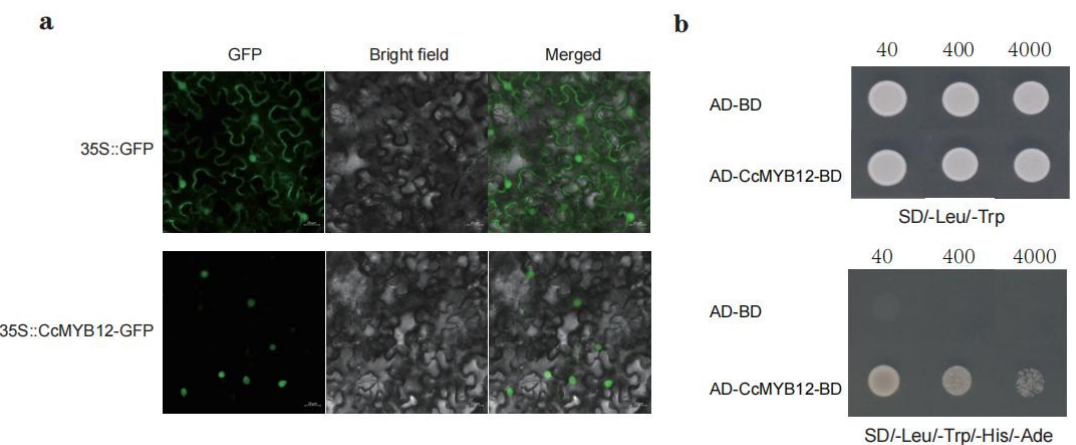
Figure 5. CcMYB12, located in nucleus, has self-activation ability. ( a ) Subcellular localization observation of CcMYB12 in tobacco system with empty GFP vector as control. ( b ) Verification of CcMYB12 self-activation ability, as tested by Y2H. Transformed yeast cells were cultured on SD/- Leu/-Trp-deficient medium and SD/-Leu/-Trp/-His/-Ade-deficient medium to test their